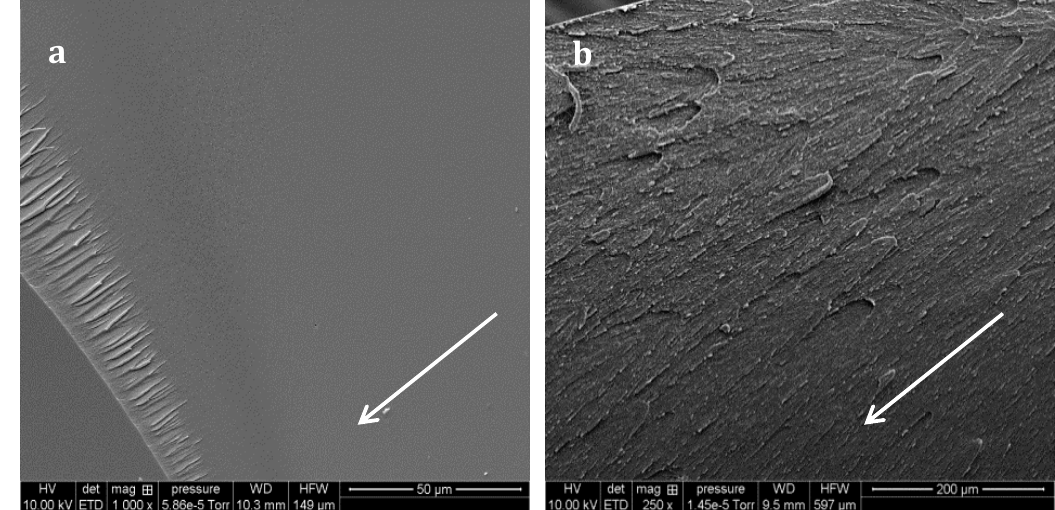
Figure 10. SEM observations of surface fracture for the neat ( a ) and f-PES modified ( b ) networks cured at 130 °C without any chemical treatment. Arrows indicate the propagation direction of cracks.